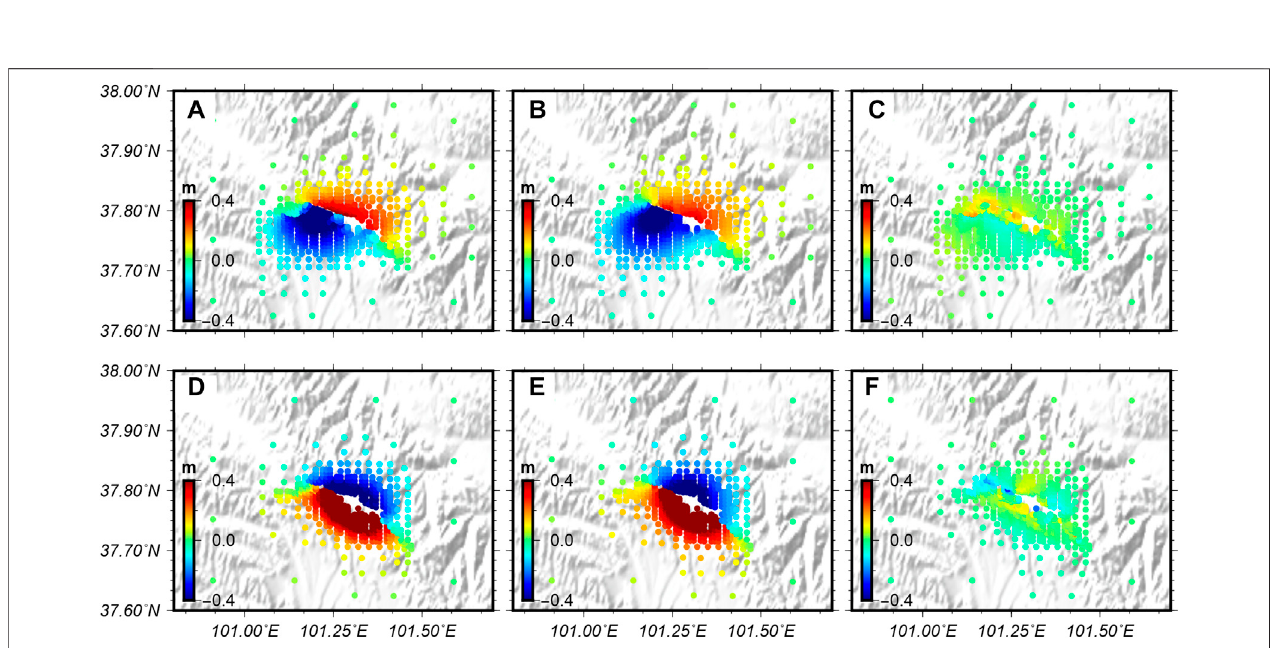
FIGURE 7 | Fitting results in distributed slip model inversion. (A – C) represent the observed deformation, simulated deformation and the fi tting residual of the T128 ascending orbit, respectively; (D – F) are same for the T33 descending orbit. The background image is DEM.